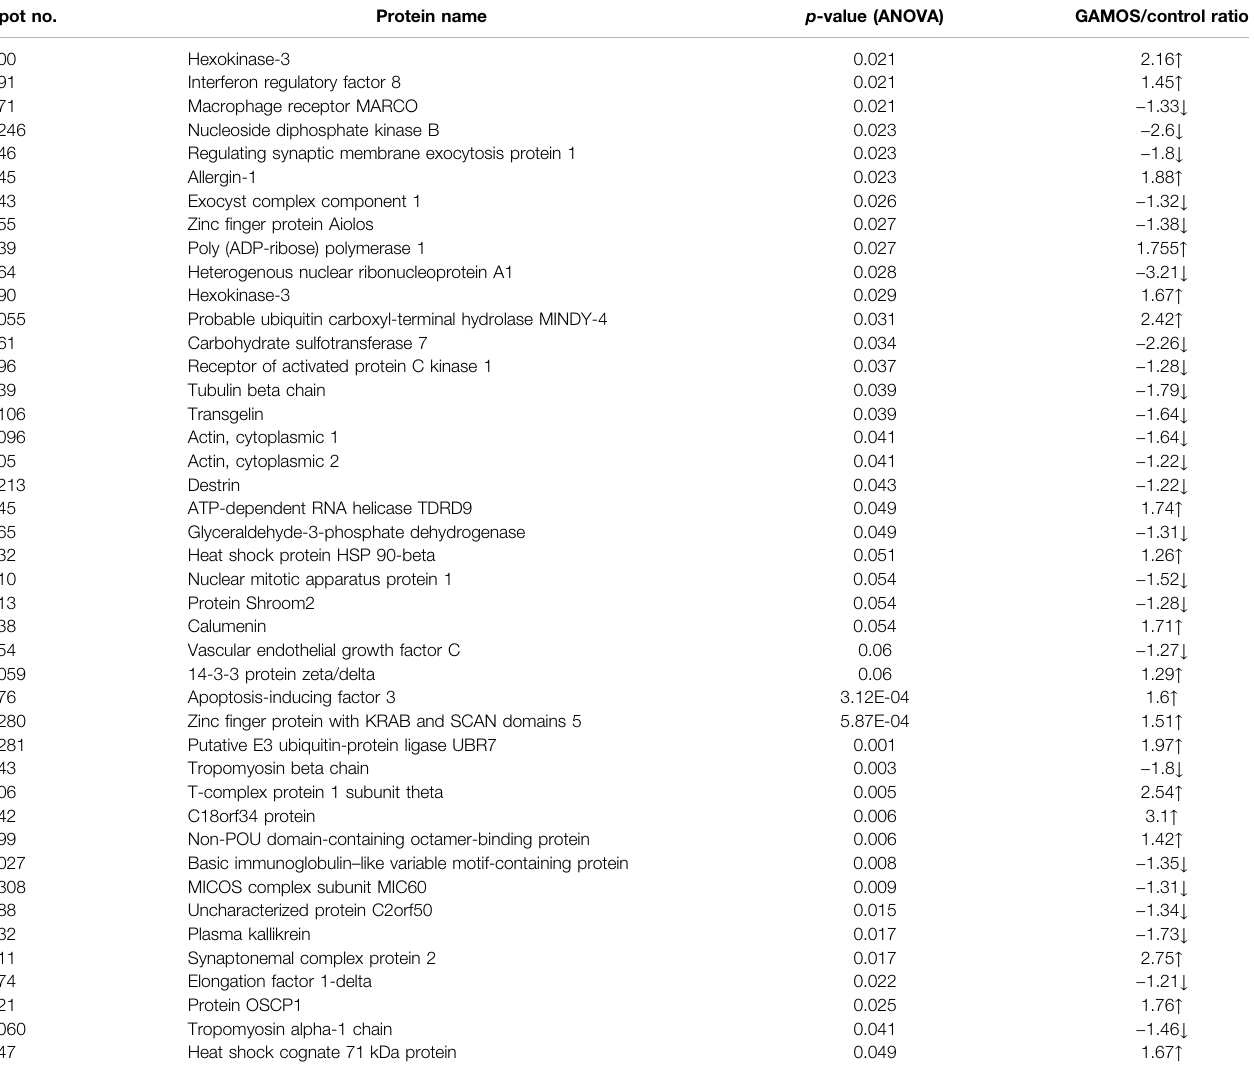
proteins are represented as nodes and their biological relationships as a line. Based on the data, three interaction networks were identi fi ed for proteins exhibiting differential expression pro fi les. The highest scoring network (score = 50; Figure 4 , Supplementary Figure S4 ) incorporated 29 proteins. The proposed highest- interaction network pathway was related to cellular assembly and organization, function and maintenance, and tissue development. Only the top pathways are shown in Figure 4A .